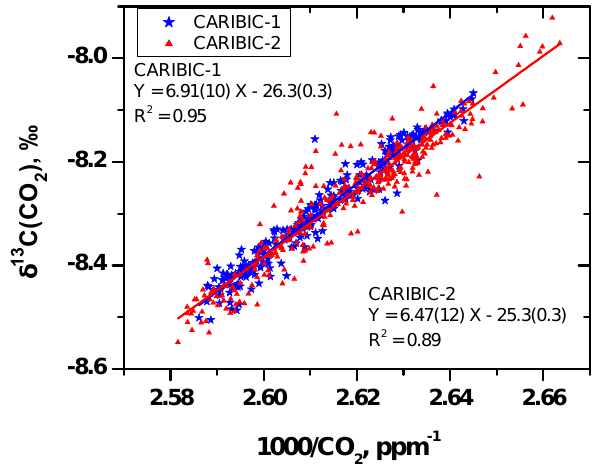
Fig. 12. Keeling plots for δ 13 C(CO 2 ) for de-trended CARIBIC-1 and CARIBIC-2 data showing close agreement (all seasons, data de-trended to 1 January 2007, latitudes > 14 ◦